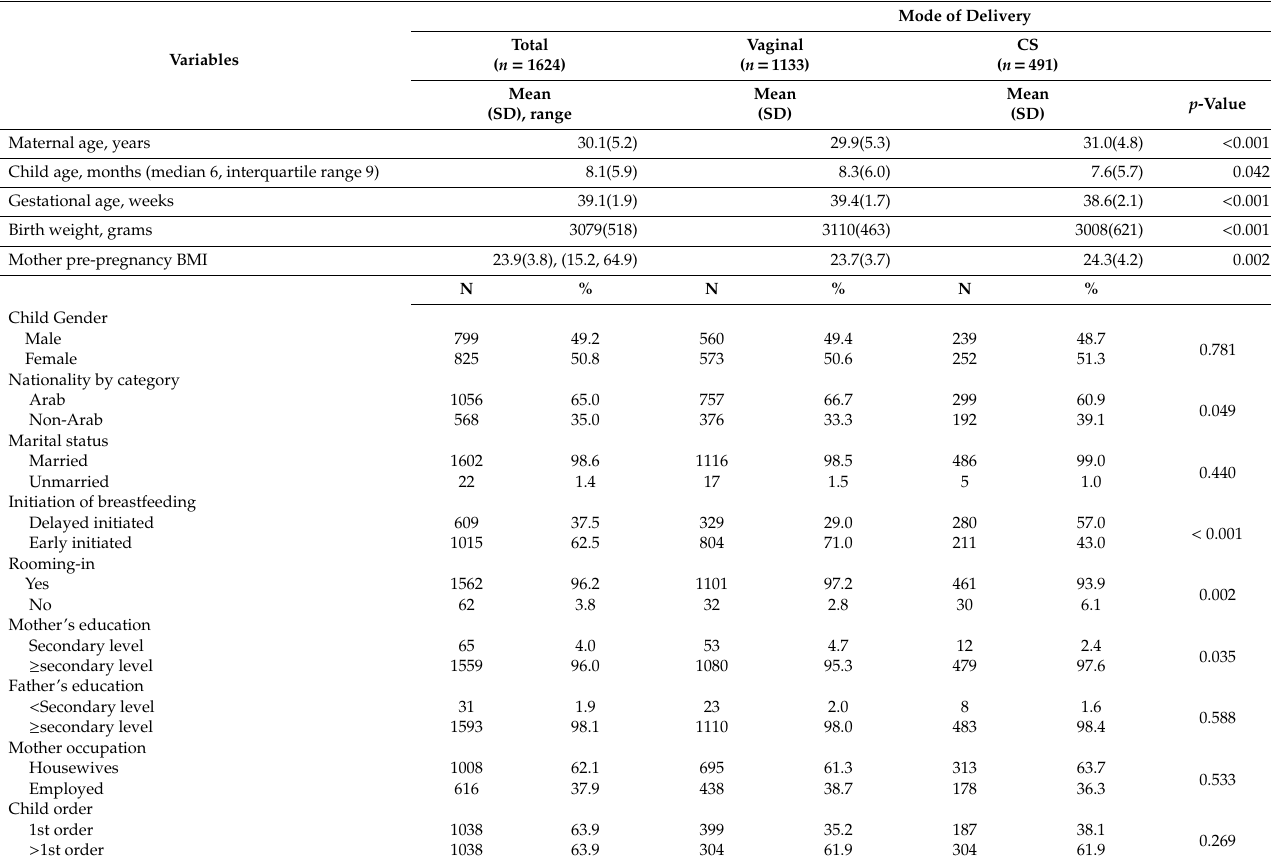
Table 1. Bivariate analysis of factors associated with caesarean section among mothers with children two years old and younger in Abu Dhabi, United Arab Emirates